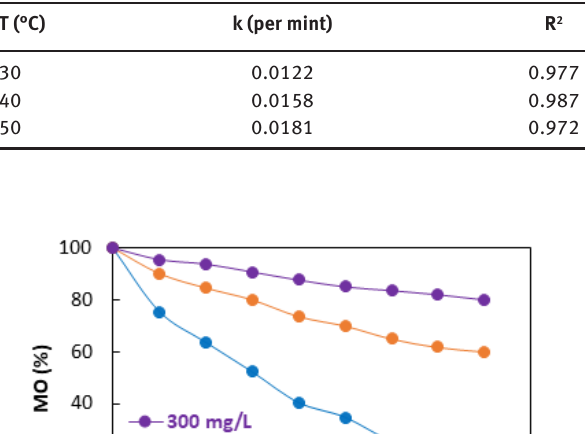
O catalyzed photo degradation of 3 4